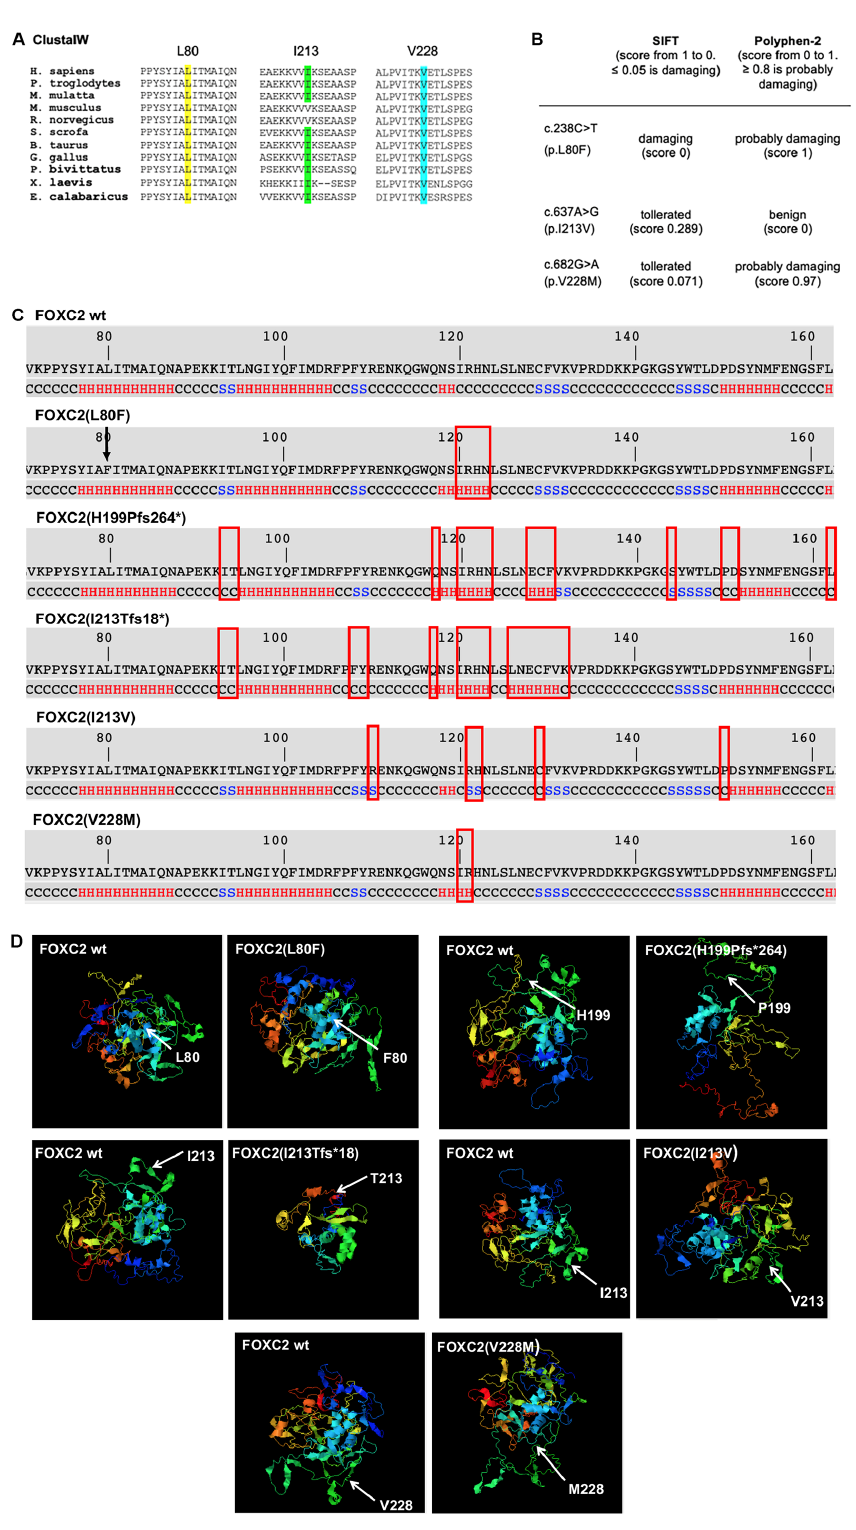
Figure 7. Bioinformatic analysis of FOXC2 mutations. ( A ) The amino acid sequence alignment of FOXC2 in 11 vertebrates ( H. sapiens, P. troglodytes, M. mulatta, M. musculus, R. norvegicus, S. scrofa, B. taurus, G. gallus, P. bivittatus, X. laevis, E. calabaricus ) showed complete conservation of leucine 80 and valine 228 and partial conservation of isoleucine 213; multiple alignments were carried out with Basic GeneBee ClustalW version 2.1, web interface. FOXC2 protein NCBI accession number: